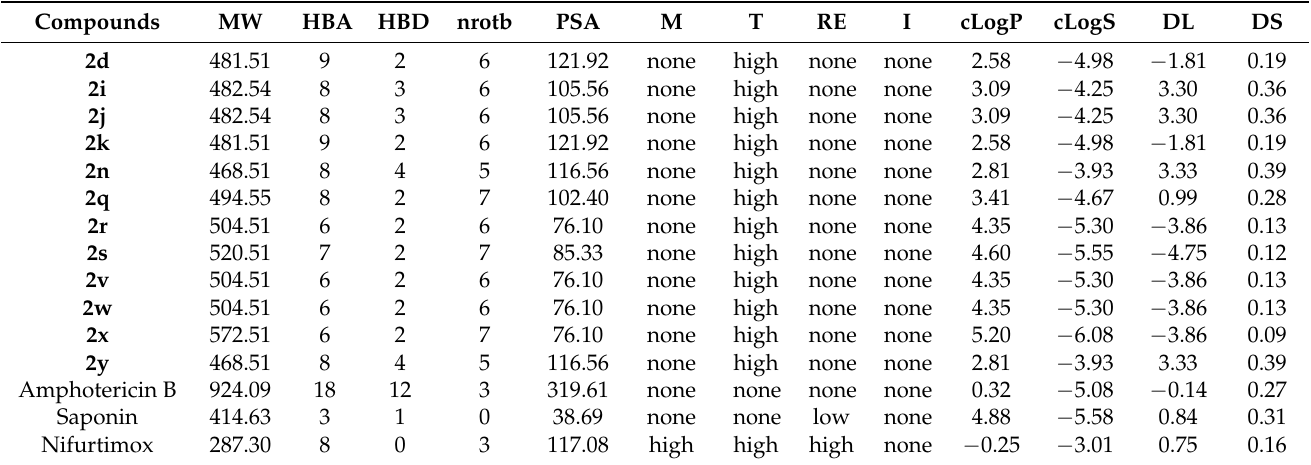
Table 4. Theoretical prediction of ADME properties a of 4,4 (cid:48) -(arylmethylene)bis(3-methyl-1-phenyl-